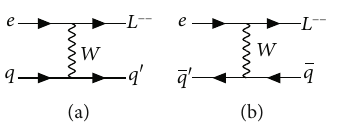
Figure 2: Feynman diagrams responsible for the